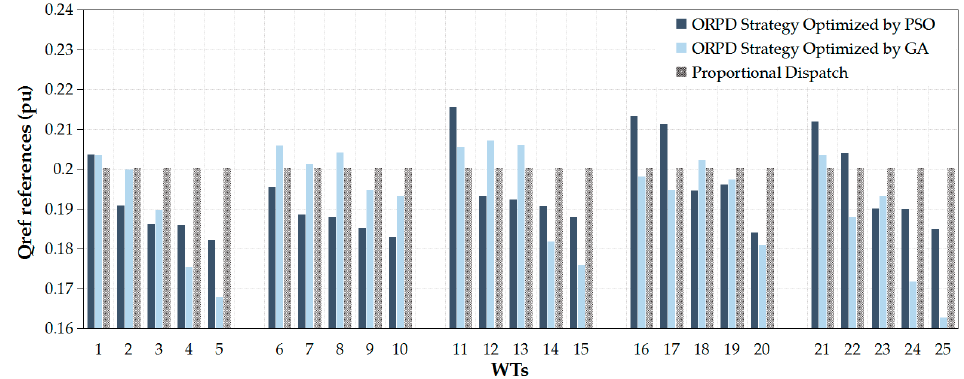
Figure 9. Distributed reactive power in WF when required reactive power references at the point of common coupling (PCC) are set to 0.2 pu.